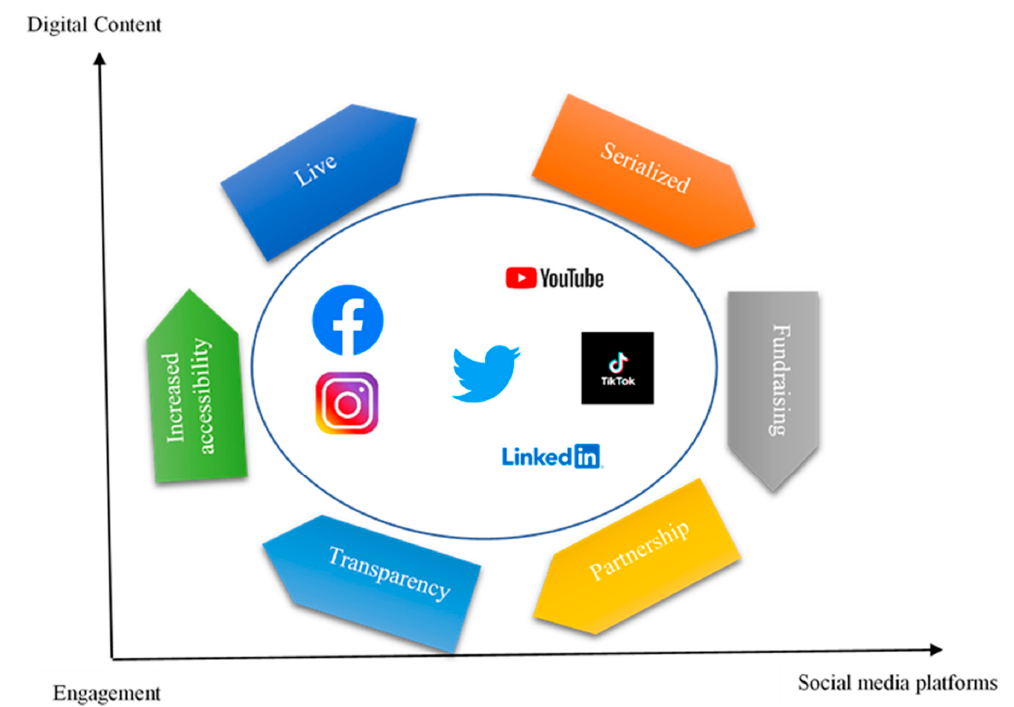
Figure 2. Social media engagement typology within cultural institutions.